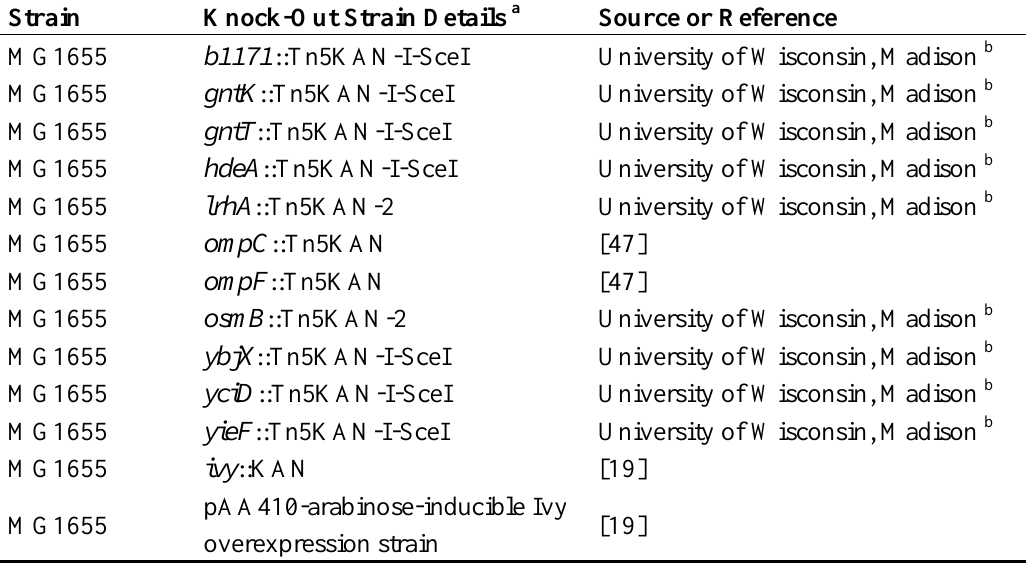
Table 2. Knock-out strains and expression strain used in this study. Strain Knock-Out Strain Details a Source or